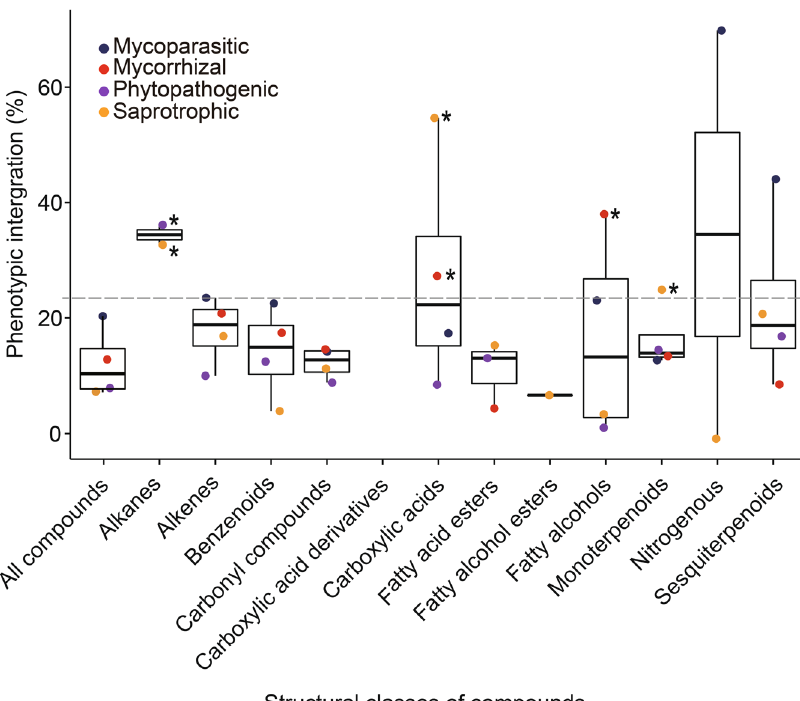
Fig. 5 Phenotypic integration (PI) of the chemical communication displays (CCDs) of fungi. The PIs are shown for different structural compound classes in different fungal functional guilds. High integration values indicate a strong covariation between compounds within the structural classes. The horizontal gray dashed line indicates the NULL-model expectation (two-sided null-hypothesis). Asterisks indicate a signi fi cant difference ( p < 0.05) compared to the NULL-hypothesis. The varying sample sizes (number of fungal species within trophic modes) were corrected as shown in the “ Methods ” section.